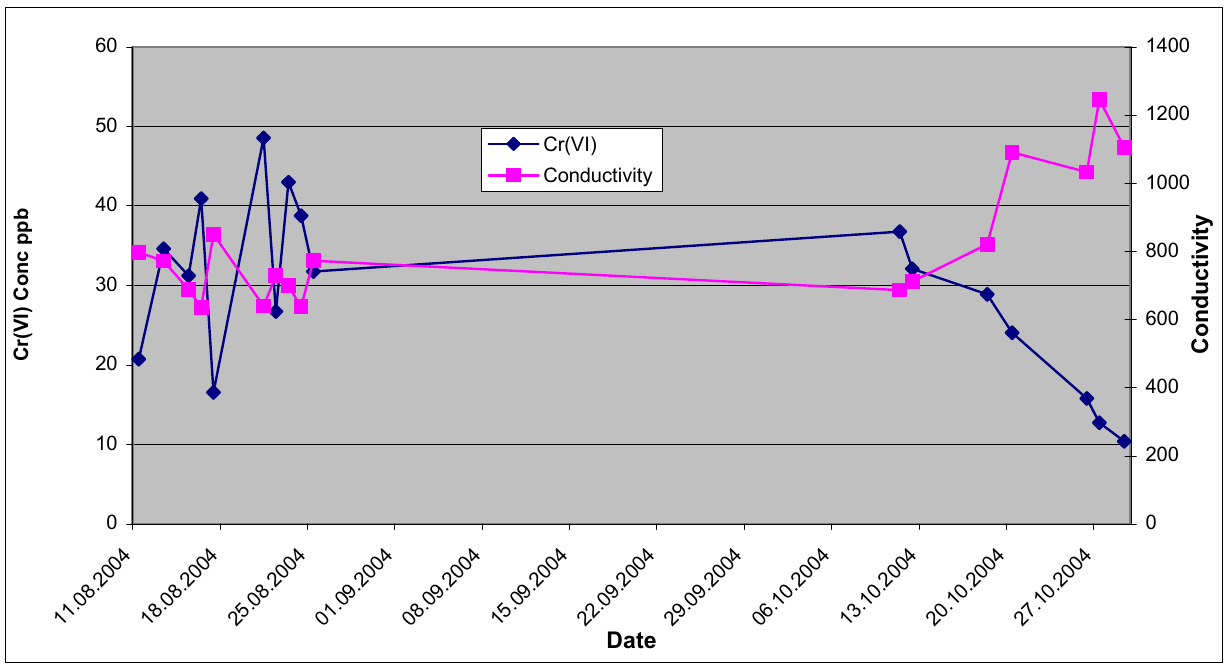
Figure 7. Hexavalent chromium & conductivity for aquifer tube DD-39-1 August 11-October 29, 2004.